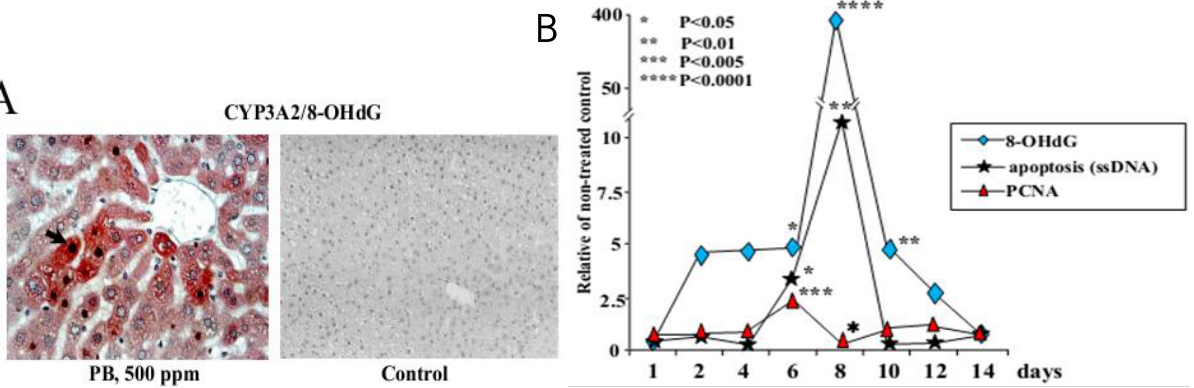
Figure 1. ( A ) Representative microphotograph of double staining for 8-OHdG (black/brown) and CYP3A2 (red) in the livers of rats treated with 500 ppm PB for 8 days (  400). Note, the increase of 8-OHdG in the nuclei of pericentrally localized hepatocytes most strongly stained for CYP3A2; ( B ) Alteration to 8-OHdG, apoptosis and cell proliferation in the liver of rats treated with 500 ppm